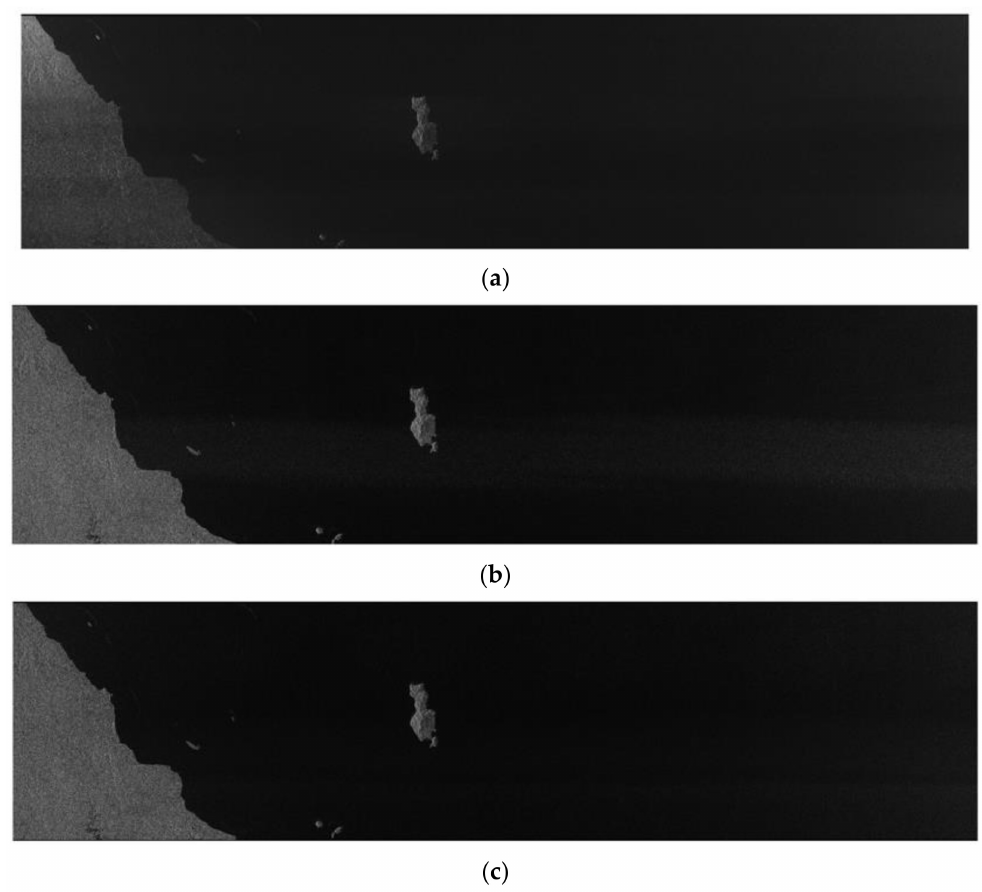
Figure 11. The RFI mitigation results for the SAR data containing RFI with a single source: ( a ) FNF; ( b ) TNF; ( c ) the proposed